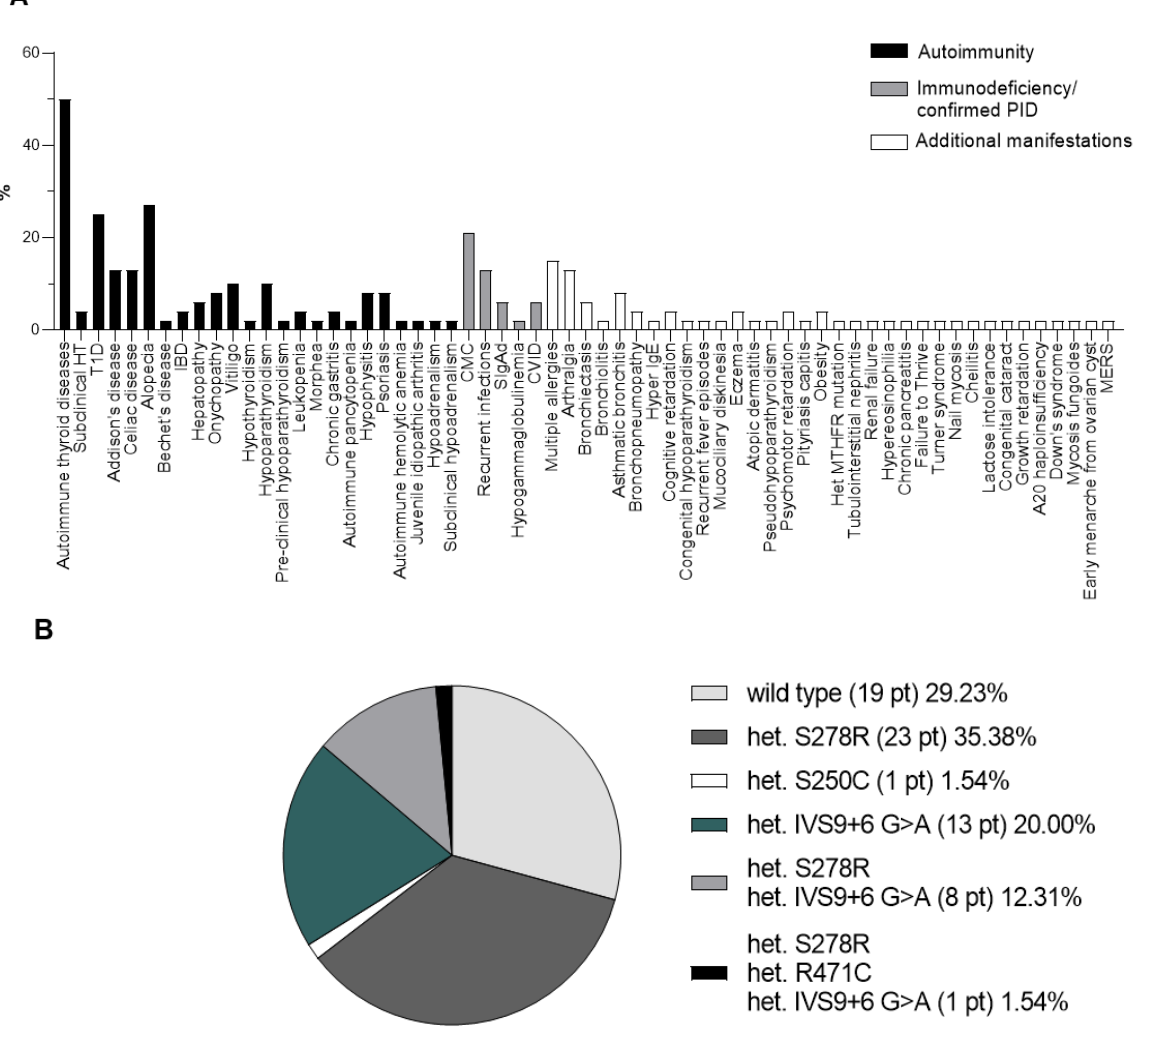
Figure 2. Statistical analysis (χ2 test) of differences in the prevalence of AIRE gene polymorphism in patients with APECED-like v ersus controls. ( A ) Prevalence of the S278R polymorphism in n = 23 patients out of the total n = 48 and controls. Statistically significant difference was observed, ** p < 0.05. ( B ) Prevalence of the IVS9+6 G>A intronic polymorphism in n = 13 patients of the total n = 48 versus controls. No statistically significant difference was observed. 4. Discussion Clinical examination of the series of patients has helped to raise physicians’ aware- ness of the possible development of different autoimmune manifestations at different ages in the same individual; autoimmunity may even be the first manifestation of PID [2]. Nowadays, PIDs include more than 430 entities [55,56], and they are associated with pol- yautoimmunity; this is especially applied to CVID and CID. In light of the foregoing, preventing the development of polyautoimmunity is a fun- damental task [6]. Furthermore, identifying a PID in a heterogeneous group of patients with several autoimmune disorders can also be a difficult task. In the presence of polyau- toimmunity, immunologic evaluation should be included at the initial diagnostic workup in order to avoid significant delay of a specific diagnosis in vulnerable patients affected by genetic immune defects.